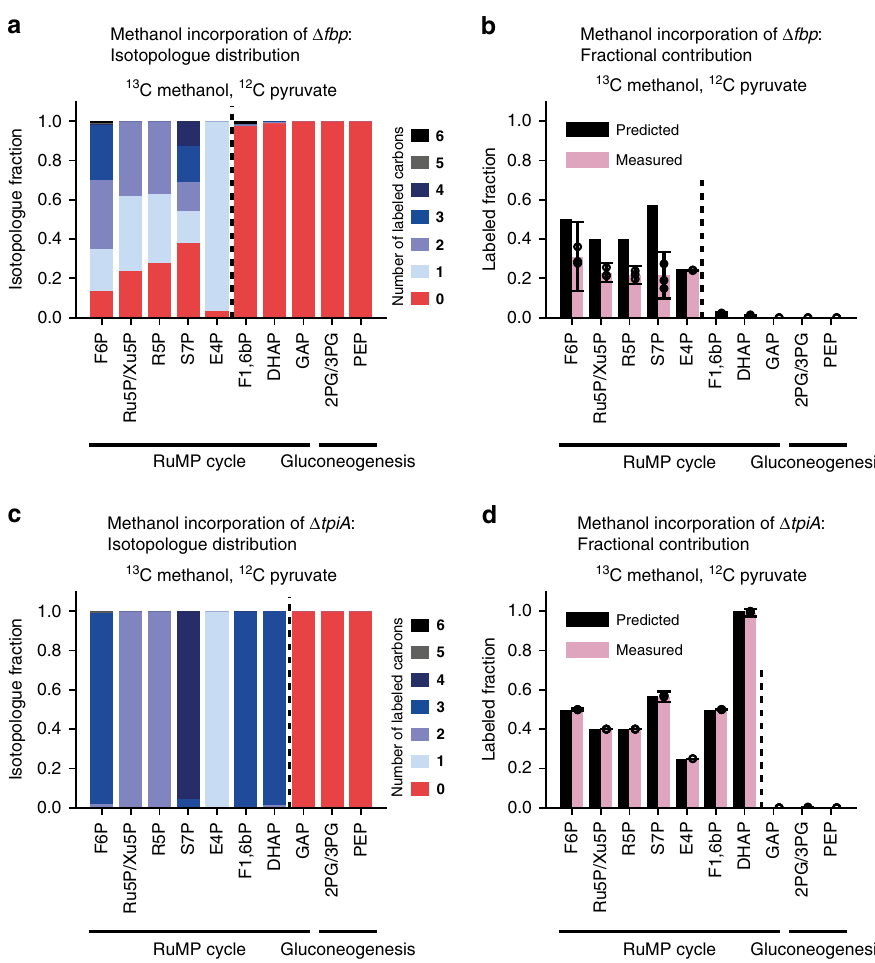
Fig. 4 Methanol incorporation into central metabolism during exponential growth. a – d 13 C isotope steady-state labeling experiment in Δ frmA Δ fbp ( n = 3) and Δ frmA Δ tpiA ( n = 5) expressing Cupriavidus necator mdh 2 CT4-1 from pSEVA424 and Methylobacillus fl agellatus hps and phi from pSEVA131. Methanol incorporation into the RuMP cycle and gluconeogenic metabolites is shown according to the isotopologue distribution ( a for Δ frmA Δ fbp ; c for Δ frmA Δ tpiA ) and labeled fraction ( b for Δ frmA Δ fbp ; d for Δ frmA Δ tpiA ). Cells were cultivated for at least 6 generations in minimal medium supplemented with 13 C methanol (500 mM) and 12 C pyruvate (20 mM) and sampled during exponential growth. A dashed line represents the location of the gene deletion ( Δ fbp or Δ tpiA ) in the metabolism; the metabolites on the left side of the line are expected to partially originate from methanol, while those on the right side are expected to be unlabeled (see also Fig. 3a, b for expected methanol incorporation into the measured metabolites). The predicted labeled fraction was based on the calculation of the methanol-derived metabolite fraction, which was calculated analogously to the methanol-derived R5P fraction (Eq. 2). The measured RuMP cycle metabolites were F6P, Ru5P/Xu5P, R5P, S7P, E4P, DHAP, GAP, and F1,6bP, and the measured gluconeogenic metabolites were 2PG/3PG and PEP. Ru5P/Xu5P and 2PG/3PG were not separable with the applied LC-MS method. The F6P isotopologue distribution and labeled fraction were calculated from UDP and UDP-glucose. E4P was detected in only 2 out of 5 replicates of strain Δ frmA Δ tpiA . Error bars represent the standard deviation. For abbreviations, see Fig. 1. Source data are provided as a Source Data fi